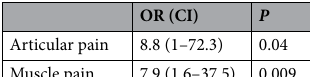
Table 4. Analysis performed excluding patients with 8–11 weeks of follow-up; the table shows the differences in the coagulation profile between patients with persistence of 3 or more symptoms at ≥ 12 weeks follow-up and patients with persistence of less than 3 symptoms at ≥ 12 follow-up. Only patients assessed after 12 weeks were included in these comparisons. VWFAg von willebrand factor antigen, RC ristocetin cofactor, F VIII factor VIII, PT prothrombin time, aPTT activated partial thromboplastin time.